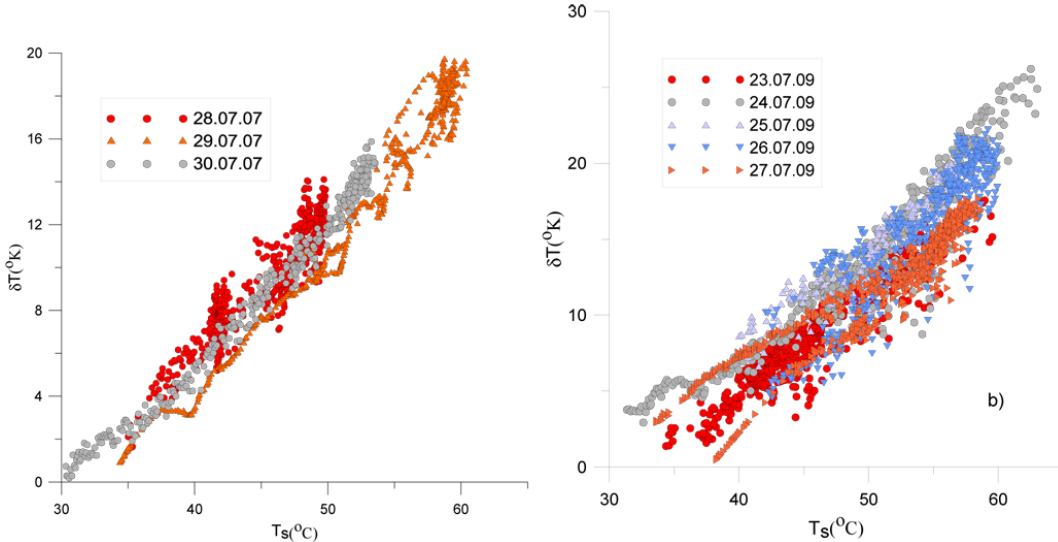
Fig. 3. The temperature difference δT between the ground surface temperature T s ( ◦ C) and the air temperature at 0.2m: (a) (data of 28– 30 July 2007), (b) (data of 23–27 July